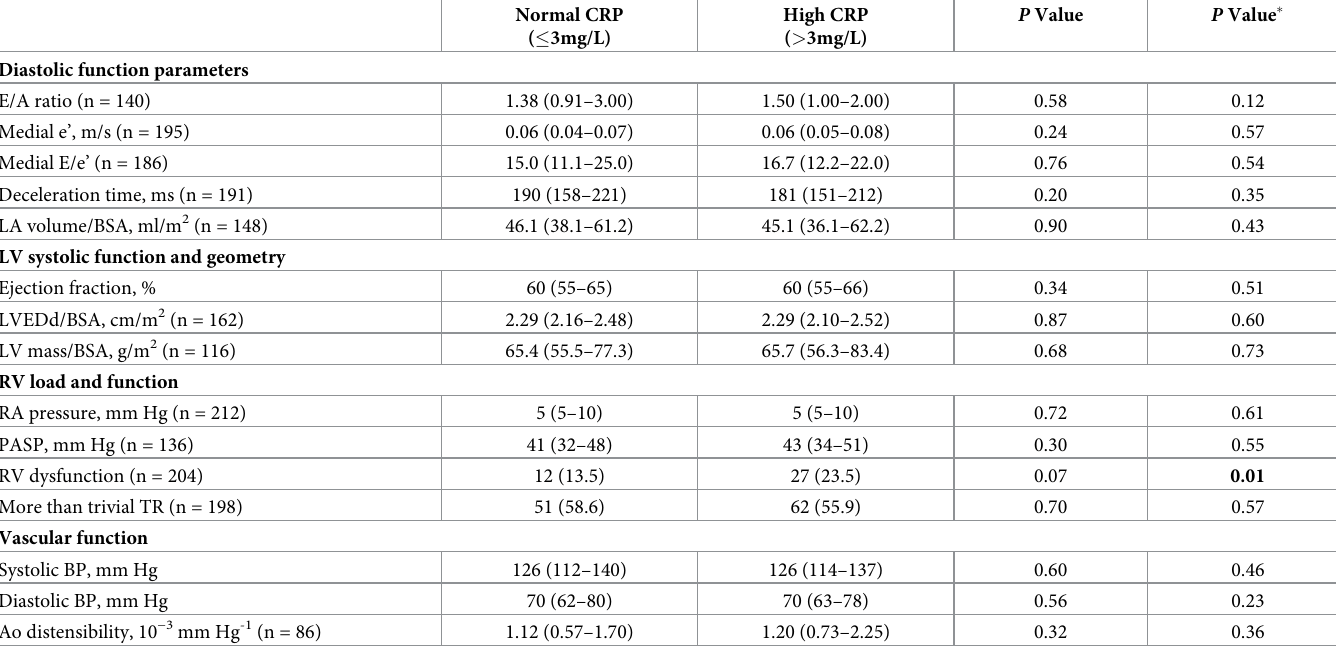
Table 4. Baseline cardiac function by C-reactive protein